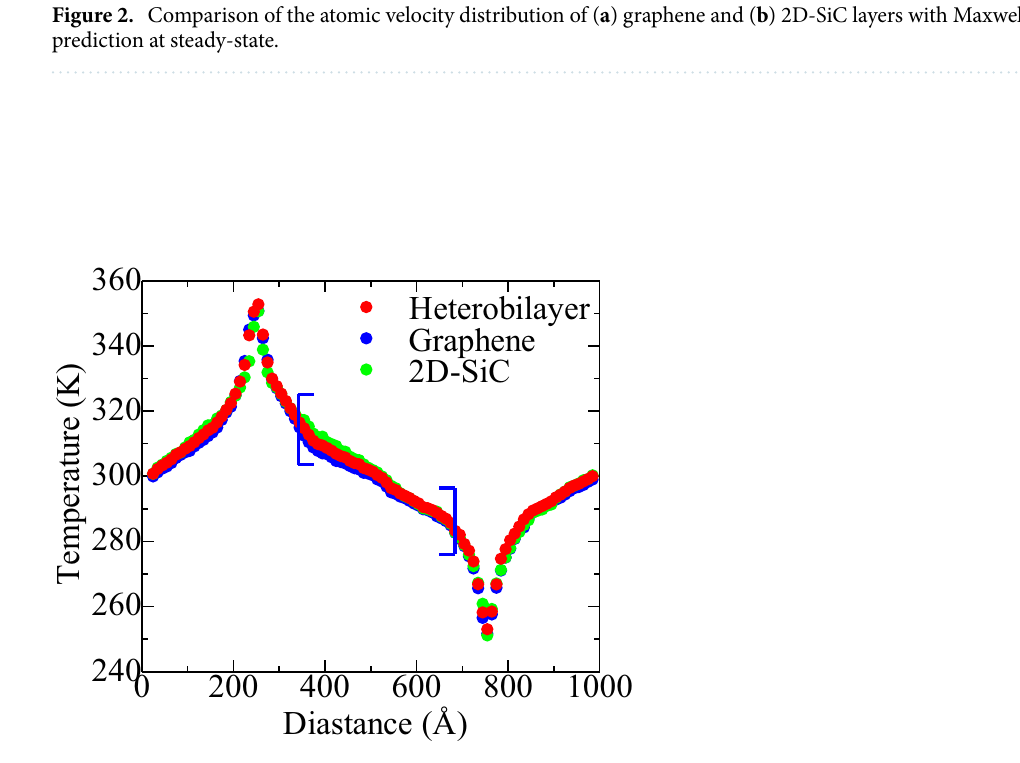
Figure 3. Temperature distribution profile of graphene, 2D-SiC, and the graphene/2D-SiC heterobilayer at steady-state and 300 K. Here the length and width of the graphene/2D-SiC heterobilayer are 100 nm and 10.8 nm, respectively. In hot and cold areas, temperature differences are approximately 300 ± 50